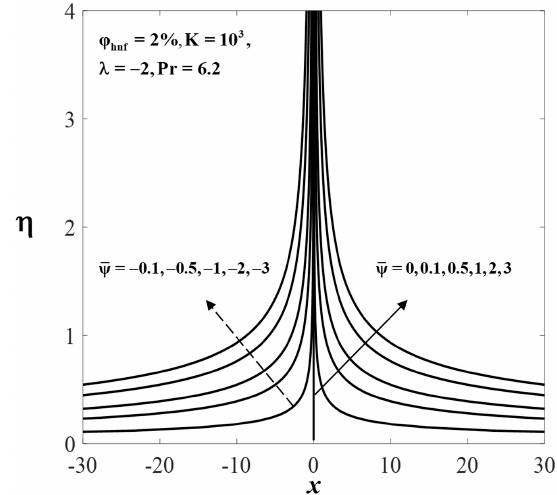
Figure 8. Streamlines for the first solution.